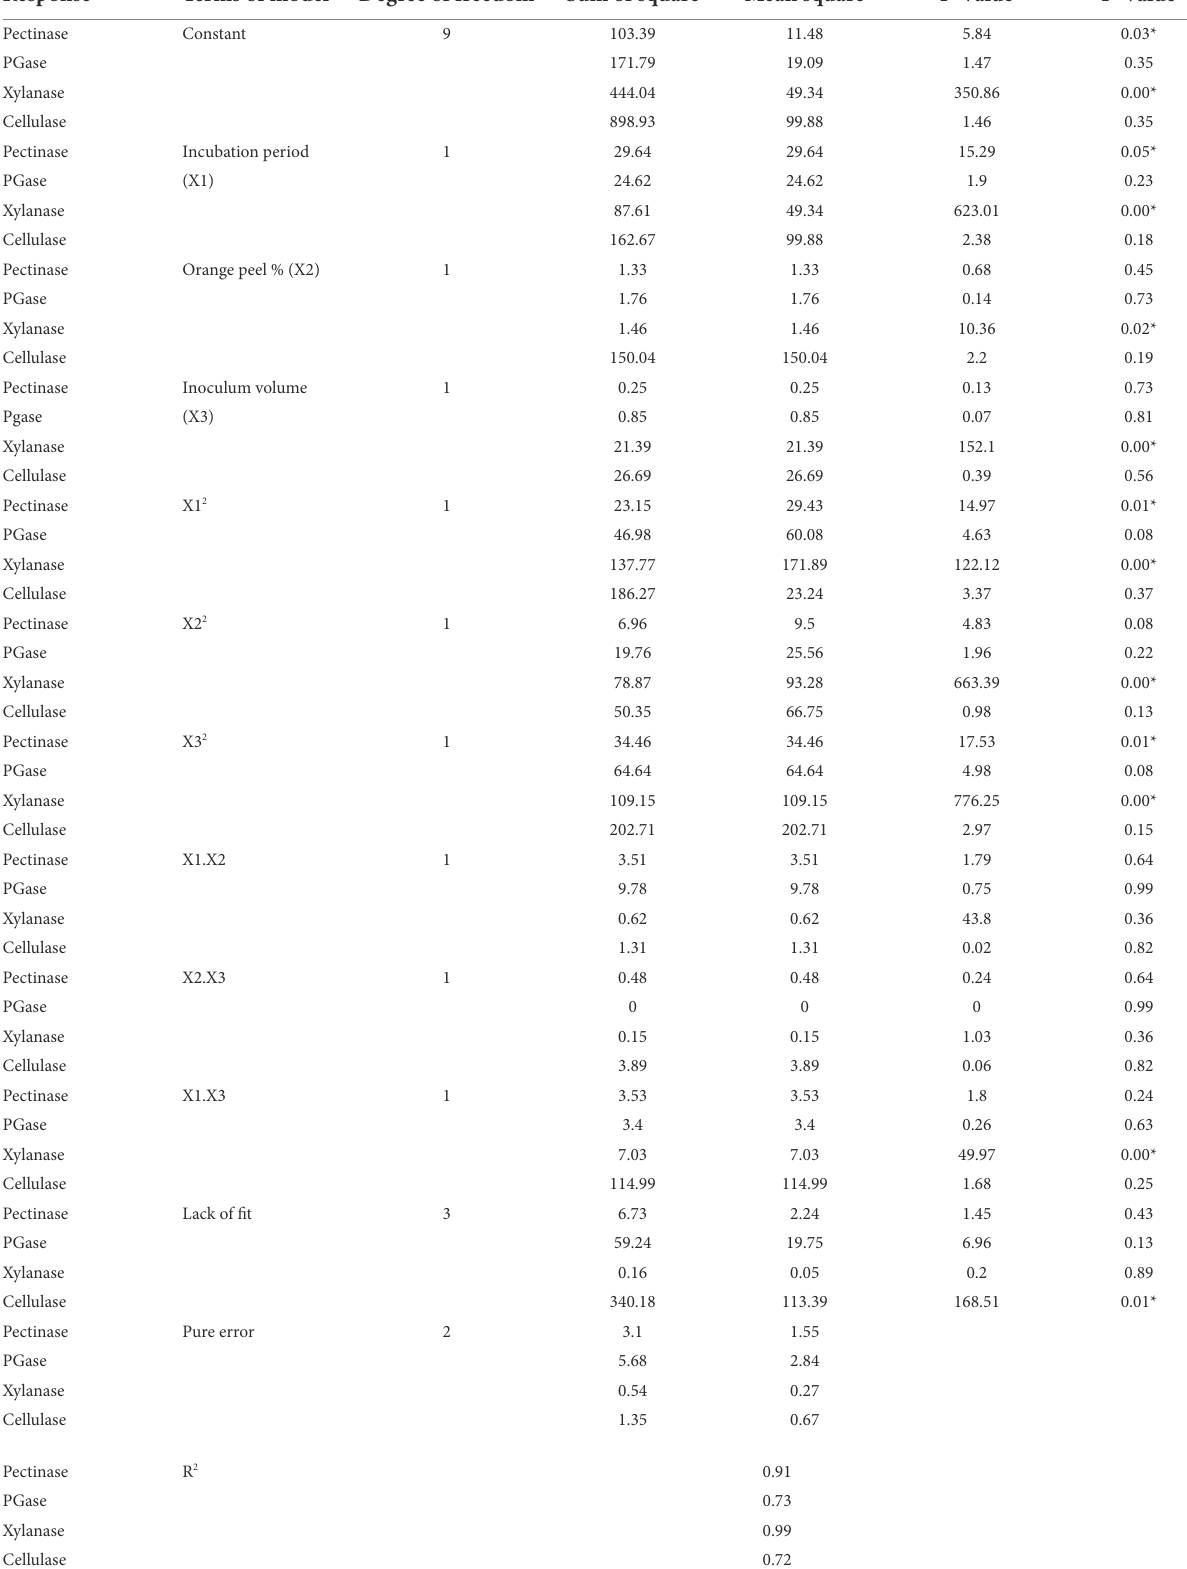
TABLE 3 Analysis of Variance (ANOVA) for BBD quadratic